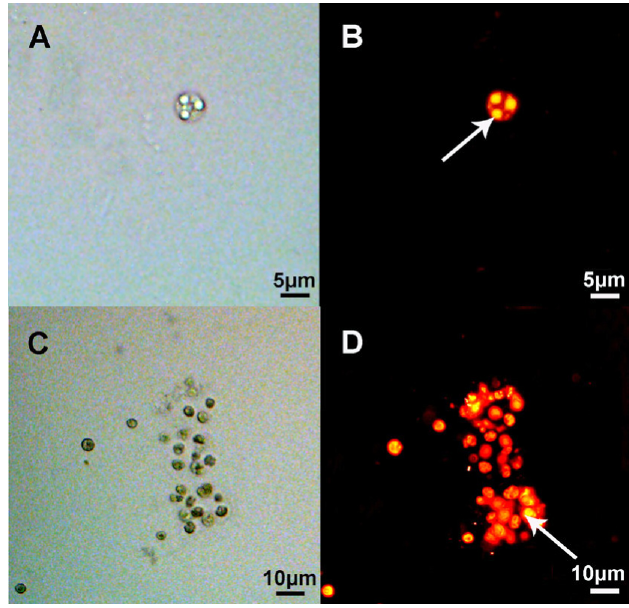
Fig. 5: Fluorescent microscopic images of TY02. (A, C) before staining with by NR, (B, D) after staining with NR (arrow points to lipid bodies). NR, Nile